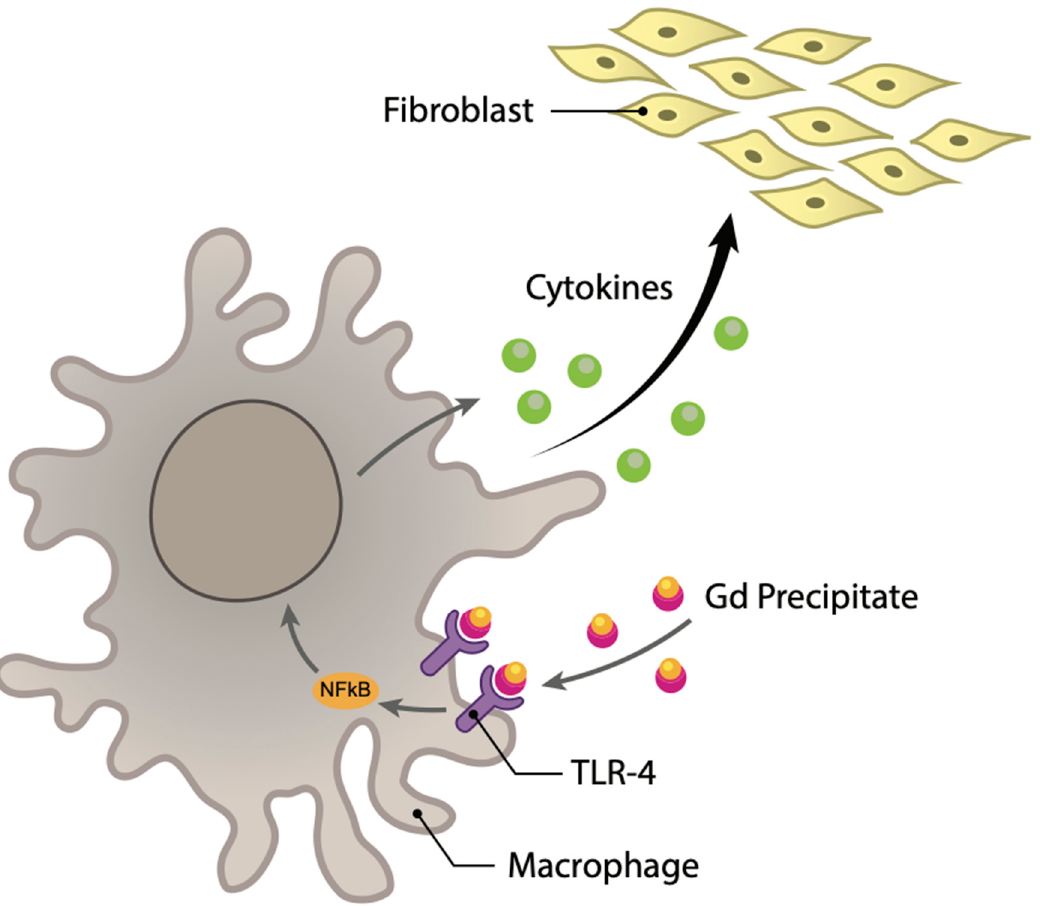
Figure 3. NSF: inflammatory response and subsequent systemic fibrotic reaction.